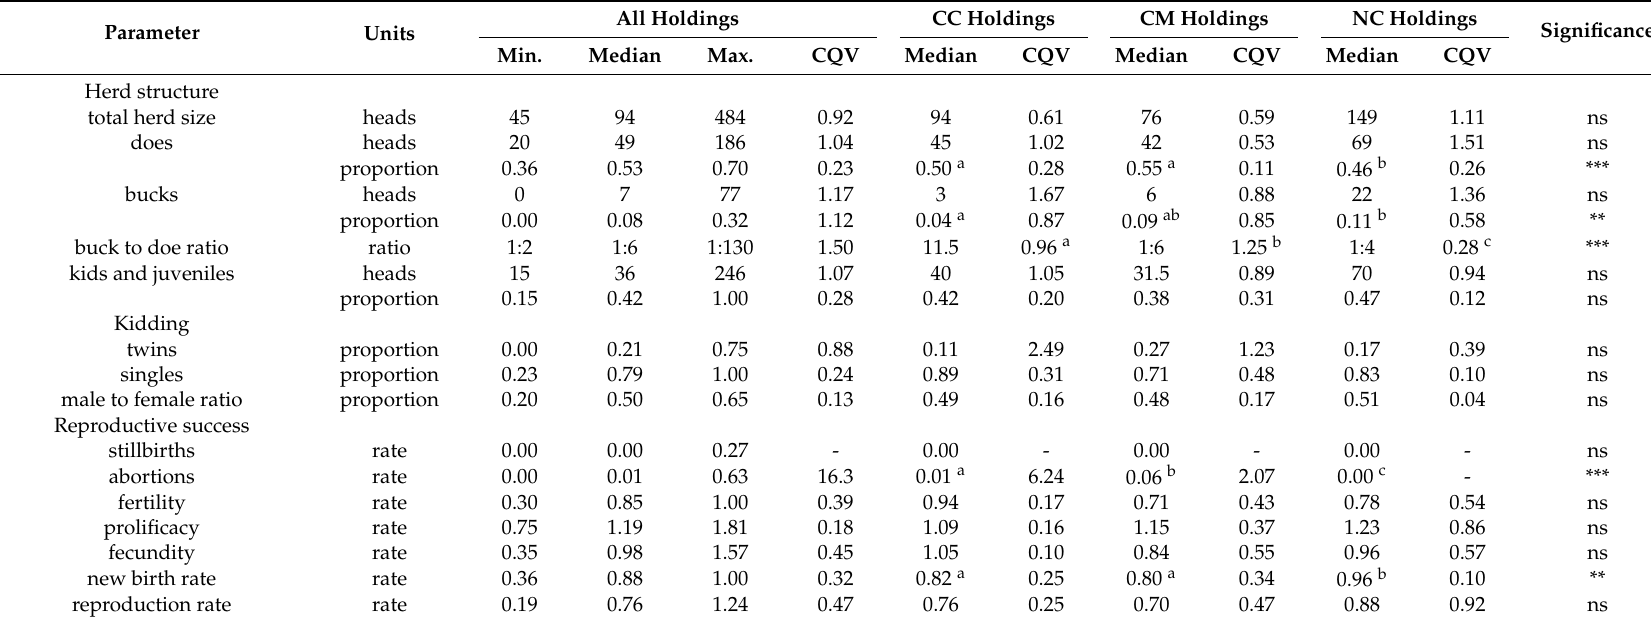
Table 4. Descriptive statistics for parameters relating to the herd structure and bio-economics of ten goat holdings in the northern region of Morocco based on monthly data collections between September 2009 and August 2012. Holdings are classified by their dairy production status: commercial cheese (CC, n = 3), commercial milk (CM, n = 4) and non-commercial dairy (NC, n =